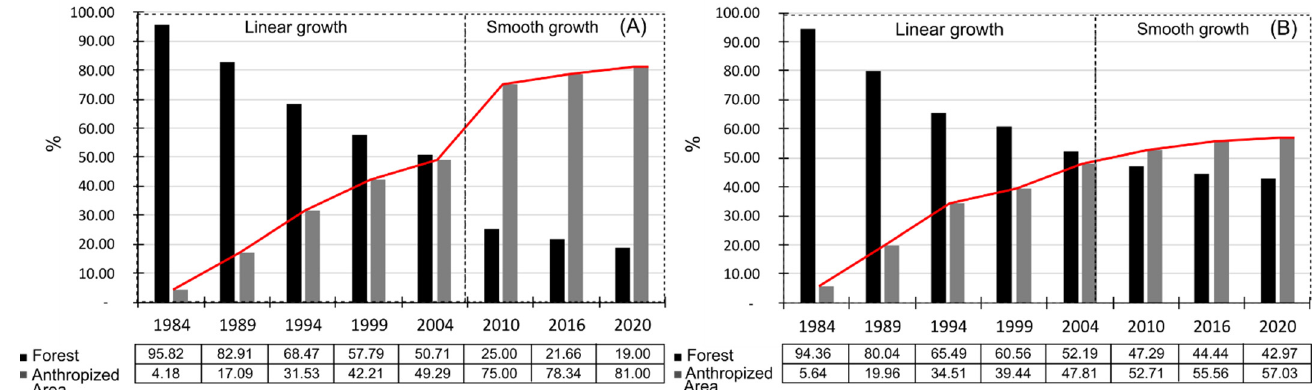
Figure 4. Evolution of anthropized areas in the fishbone ( A ) and topographic or disorganised multidirectional models ( B ).